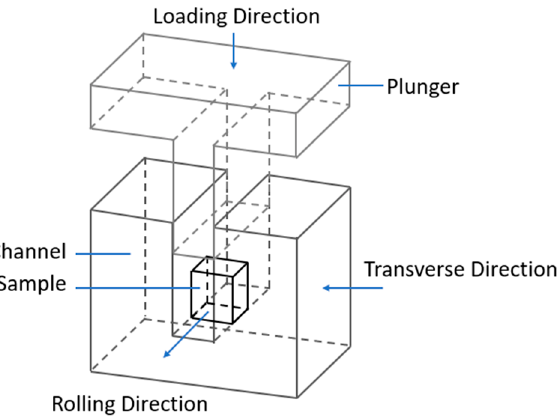
Figure 2. Schematic of a channel die testing rig with sample compressed in plane strain condition.